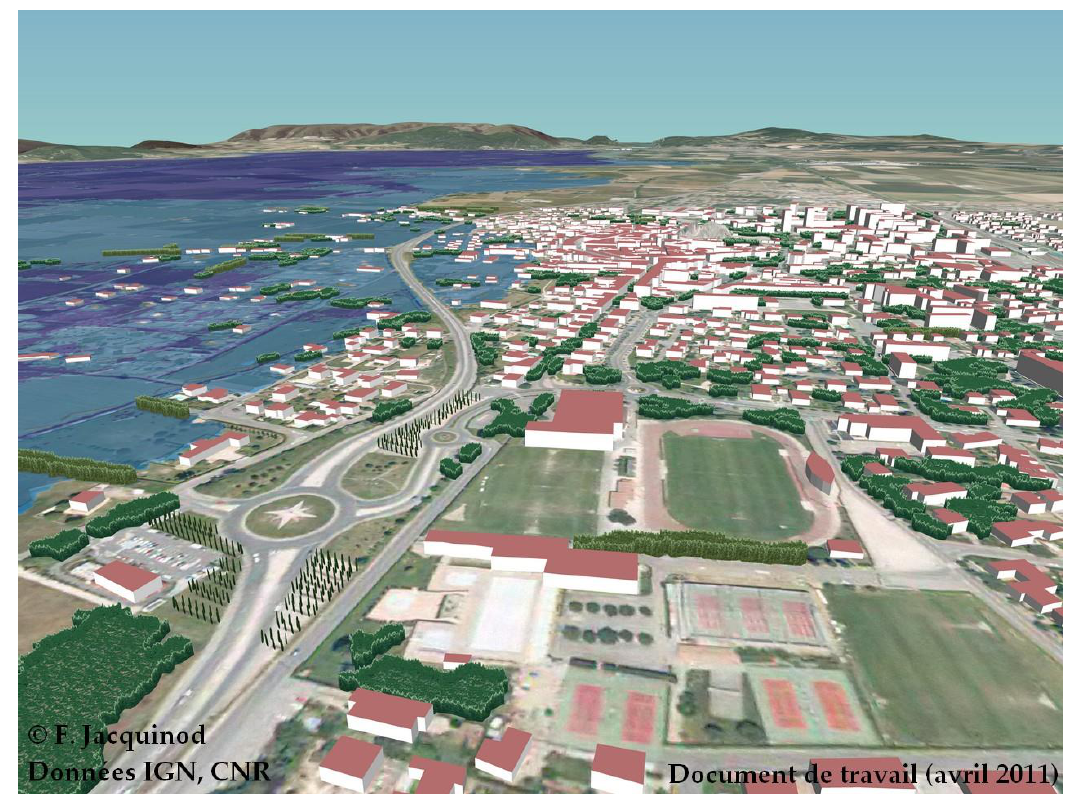
Figure 1. Aerial view from a 3D geovisualization of a district impacted by a simulated flood. Image prepared by F. Jacquinod from data from IGN and CNR.